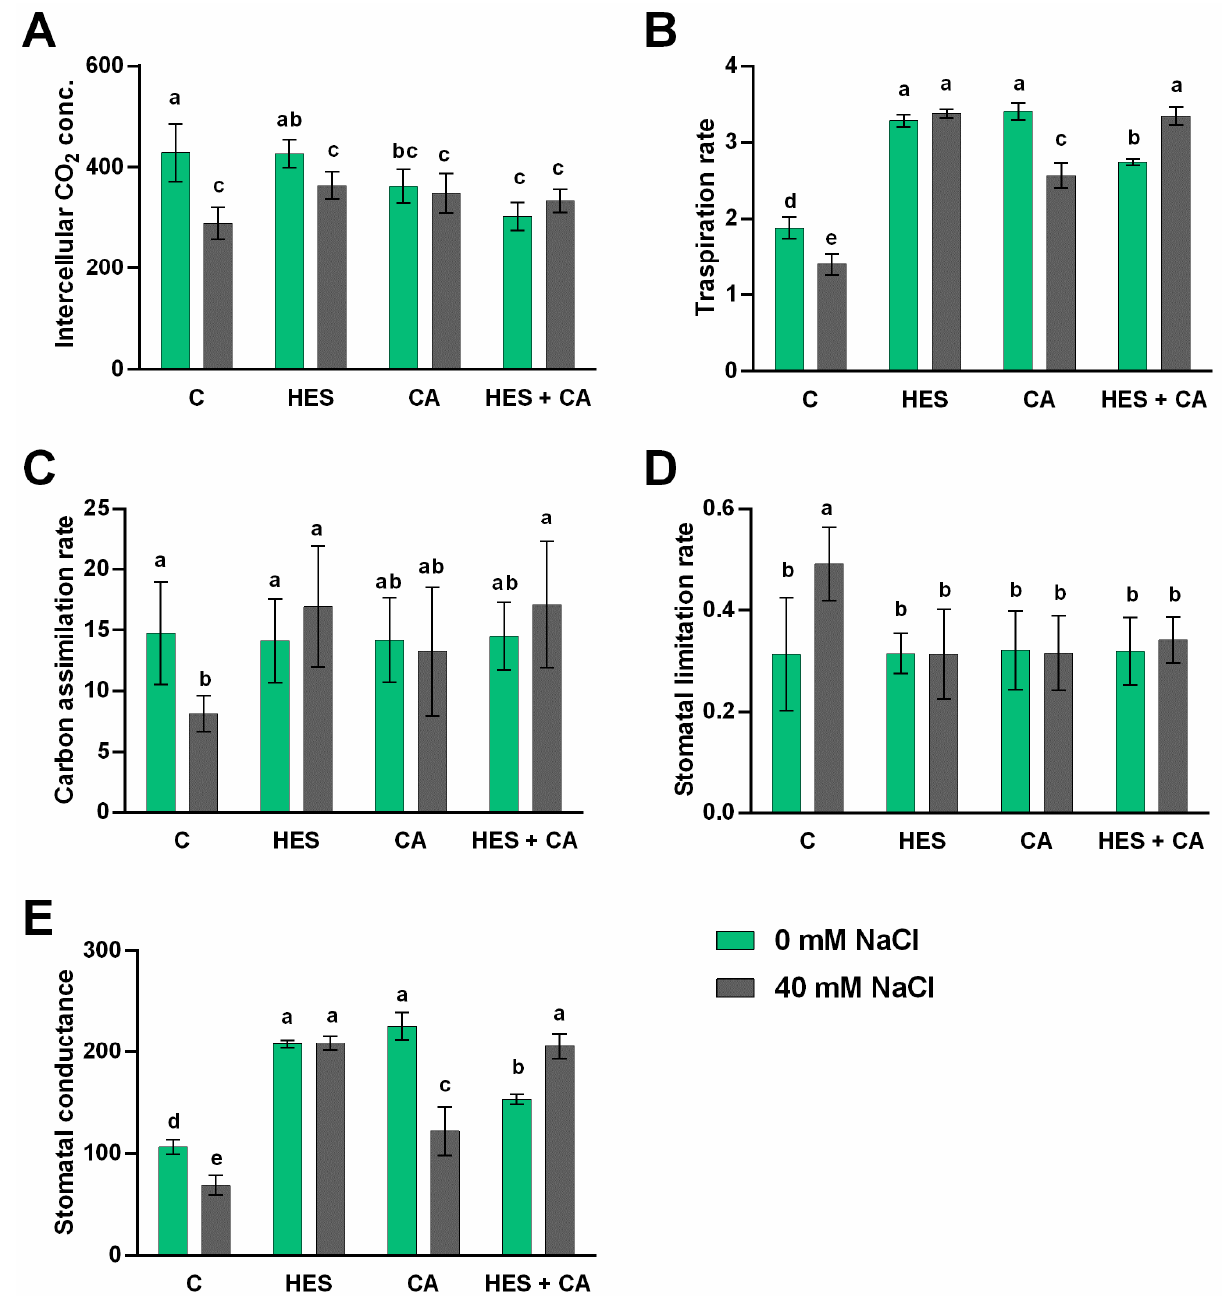
Figure 2. ( A ) Intercellular CO 2 concentration (Ci), ( B ) transpiration rate (E), ( C ) carbon assimilation rate (An), ( D ) stomatal limitation rate (Ls), and ( E ) stomatal conductance (gs) of lettuce after 10 days of treatments; the values are expressed as mean percentage ± standard deviation of eight replicates. The lettuce plants were treated with: control no treated ( C ), 100 μ M hesperidin (HES), 50 μ M chlorogenic acid (CA), 100 μ M HES + 50 μ M CA. Treatments were performed both under salt (40 mM NaCl) and non-salt (0 mM NaCl) stresses. The statistical significance has been tested by a one-way ANOVA test with Tukey post-test multiple comparisons ( p -value < 0.05), and significant differences between treatments are indicated by the lowercase letters above each bar.